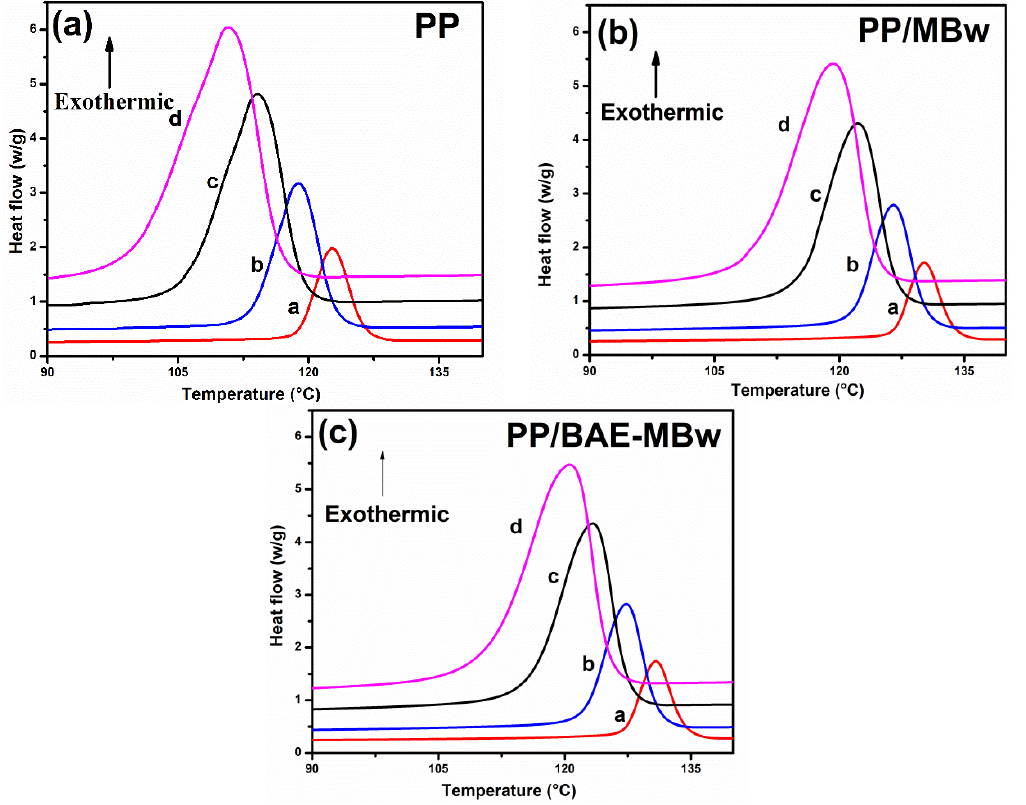
Figure 3. Differential scanning calorimetry (DSC) thermograms of non-isothermal crystallization of ( a ) PP, ( b ) PP/MBw, and ( c ) PP/BAE-MBw composites (cooling rate: a — 5 °C/min, b — 10 °C/min, c — 20 °C/min, d — 30 °C/min). Table 1. Basic crystallization parameters of PP and its composites at different cooling rates.